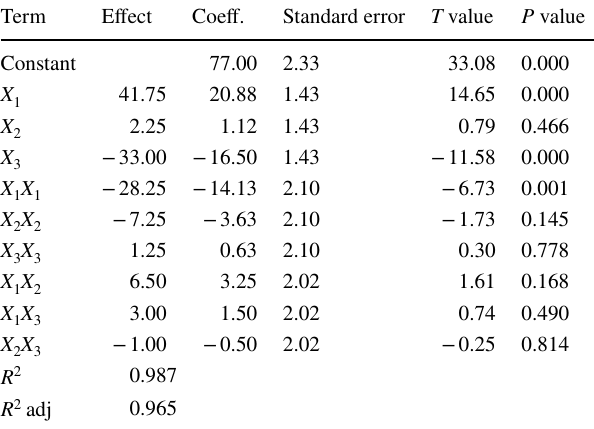
Table 4 Estimated value of coefficient regression for the fitted quad- ratic polynomial model of Cr(VI) ion